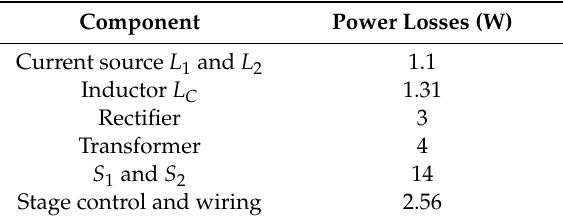
Figure 13. Electrical signals of the second array ( a ) input and output power, ( b ) e ffi ciency implemented. Table 6. Total power losses distribution by applying SiC power devices.